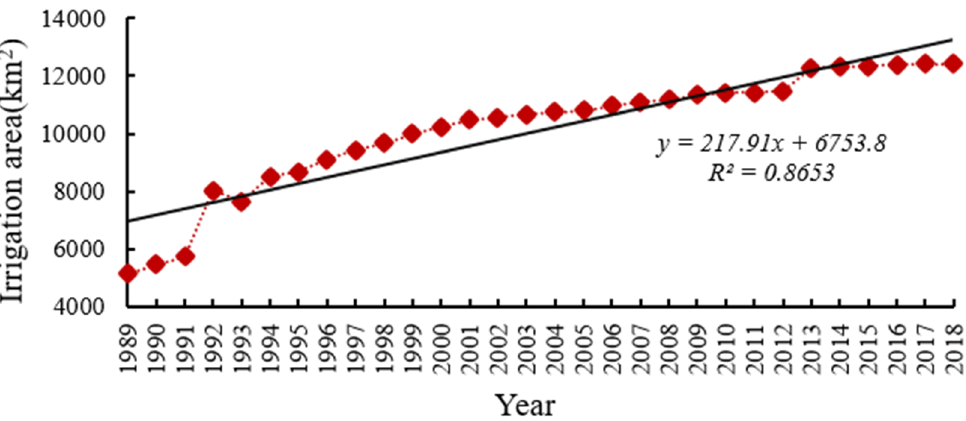
Figure 11. The trend of an irrigation area in the Hetao Plain from 1989 to 2018. Table 4. Multiple linear regression analyses of the water body area and water body number with climatic and anthropogenic driving factors in the Hetao Plain. The six dependent variables are maximum water body area, maximum water body number, year-long water body area, year-long water body number, seasonal water body area, and seasonal water body number. AP and AT are the Hetao Plain annual cumulative precipitation and annual average temperature respectively, the three dependent variables are AP, AT, and Irrigation. R 2 is the proportion of variance in the dependent variable, which can be explained by the selected explanatory variables. SEE is the standard error of the estimate. F and Sig. are the F-statistic and the p-value associated with it. For each linear regression,